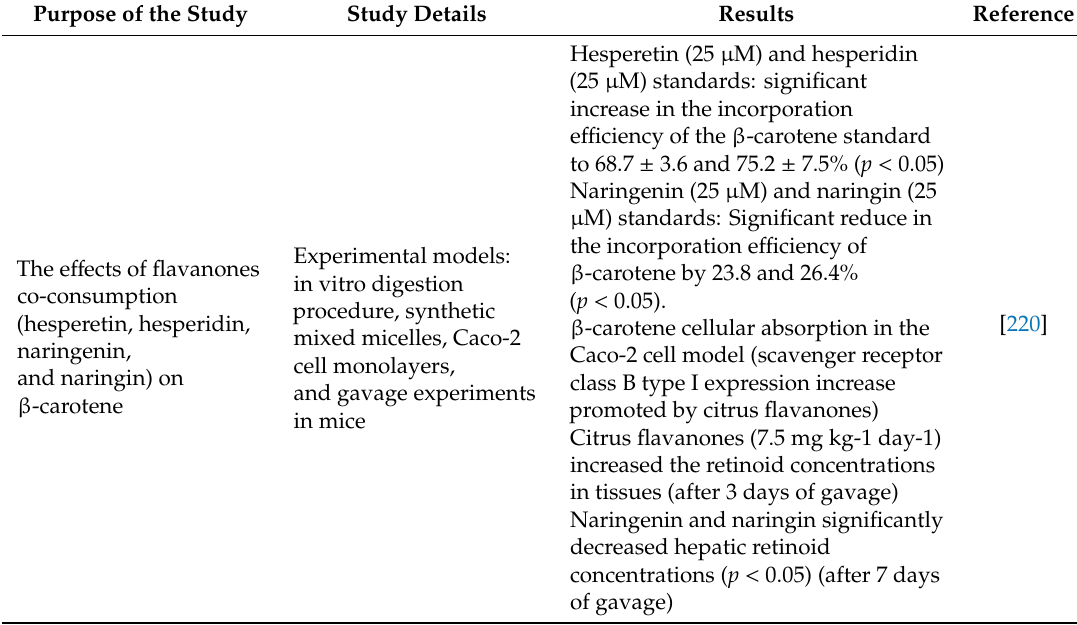
Table 4. The role of food constituents in the bioavailability of